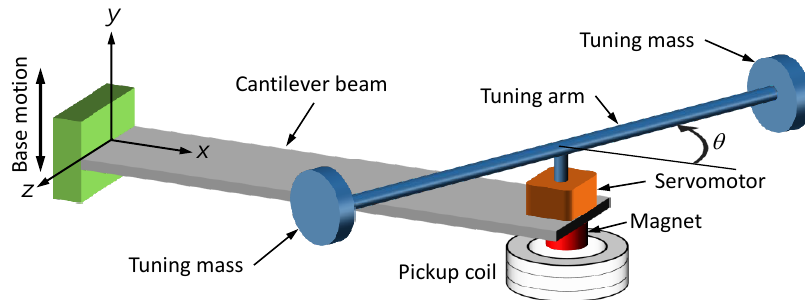
Figure 1. Schematic illustration of variable-inertia device